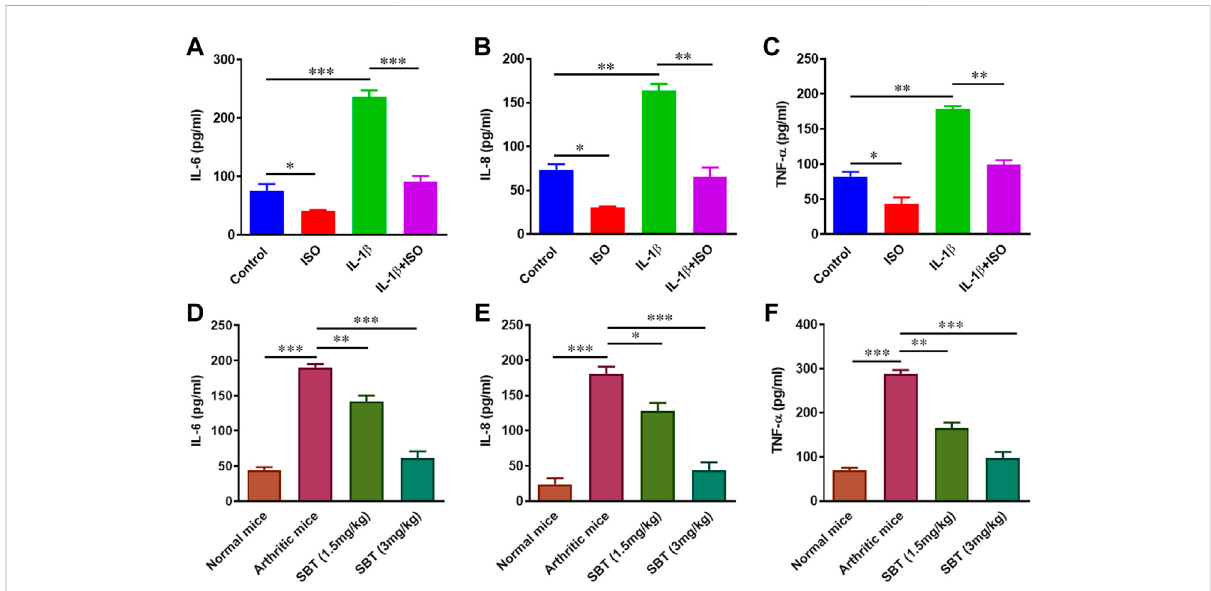
FIGURE 4 Protein quanti fi cation analysis of pro-in fl ammatory cytokines in vitro and in vivo . CHON-001 cells were treated with ISO (10 − 5 mol/L), IL-1 β (10 ng/ml) or combination of both for 24 h and cell supernatants were collected. Protein levels ofIL-6 (A) , IL-8 (B) and TNF- α (C) were analyzed by ELISA. Articular chondrocytes were cultured in complete DMEM medium for 24 h. After incubation, cell supernatants were collected and ELISA was performed to quantify IL-6 (D) , IL-8 (E) and TNF- α (F) atproteinlevels in murine chondrocytes. Pro-Quantum software was used to analyze the results. All experiments were performed in duplicates. Signi fi cance of data was measured by using One Way ANOVA. * p < 0.05, ** p < 0.01, *** p < 0.001.